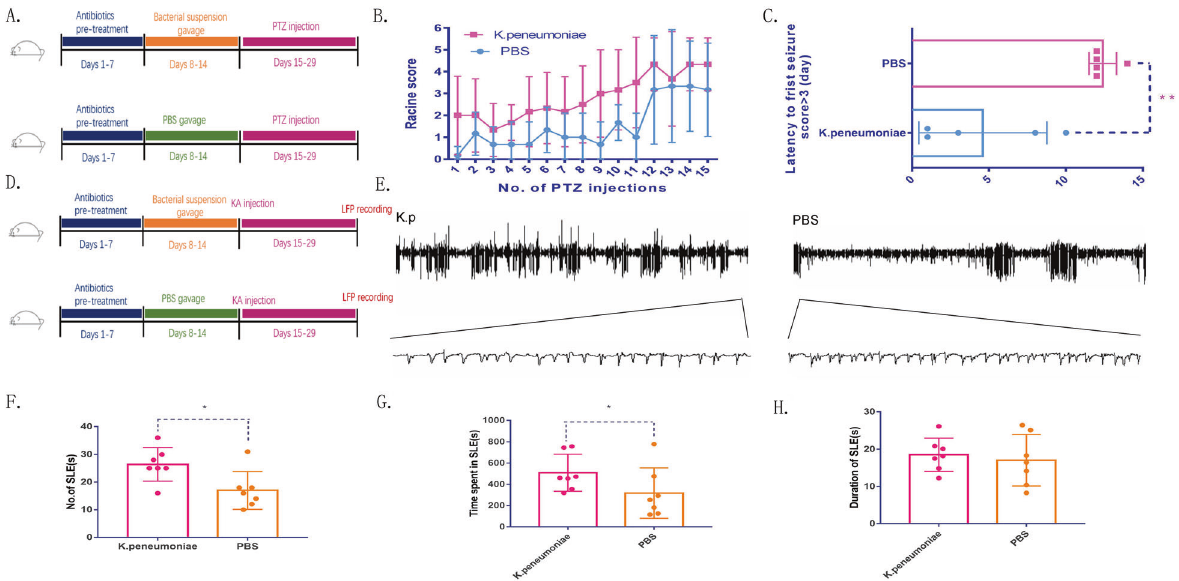
Fig. 2 K. pneumoniae increases seizure susceptibility. A Graphic representation of the intervention timeline in the PTZ experiment. B In the PTZ kindling mouse model, the seizure score was higher in the K. pneumoniae group than in the PBS group after the PTZ injection ( n = 6 in each group. Error bars represent the means ± SEMs; * P < 0.05, ANOVA). C K. pneumoniae group mice exhibited a signi fi cantly shortened latency time to the fi rst seizure, scoring > 3 (** P < 0.01, n = 6 in each group, Student ’ s t -tests). D Graphic representation of the intervention timeline in the KA experiment. E Representative LFPs in the two groups. F During 30 min of recodring, the number of SLEs was signi fi cantly higher in the K. pneumoniae group than in the PBS group (* P < 0.05, n = 7 in each group, Student ’ s t test). G The total time spent in SLEs during the 30 min was signi fi cantly higher in the K. pneumoniae group than in the PBS group (* P < 0.05, n = 7 in each group, Student ’ s t test). H The duration of SLEs was not signi fi cantly changed between the